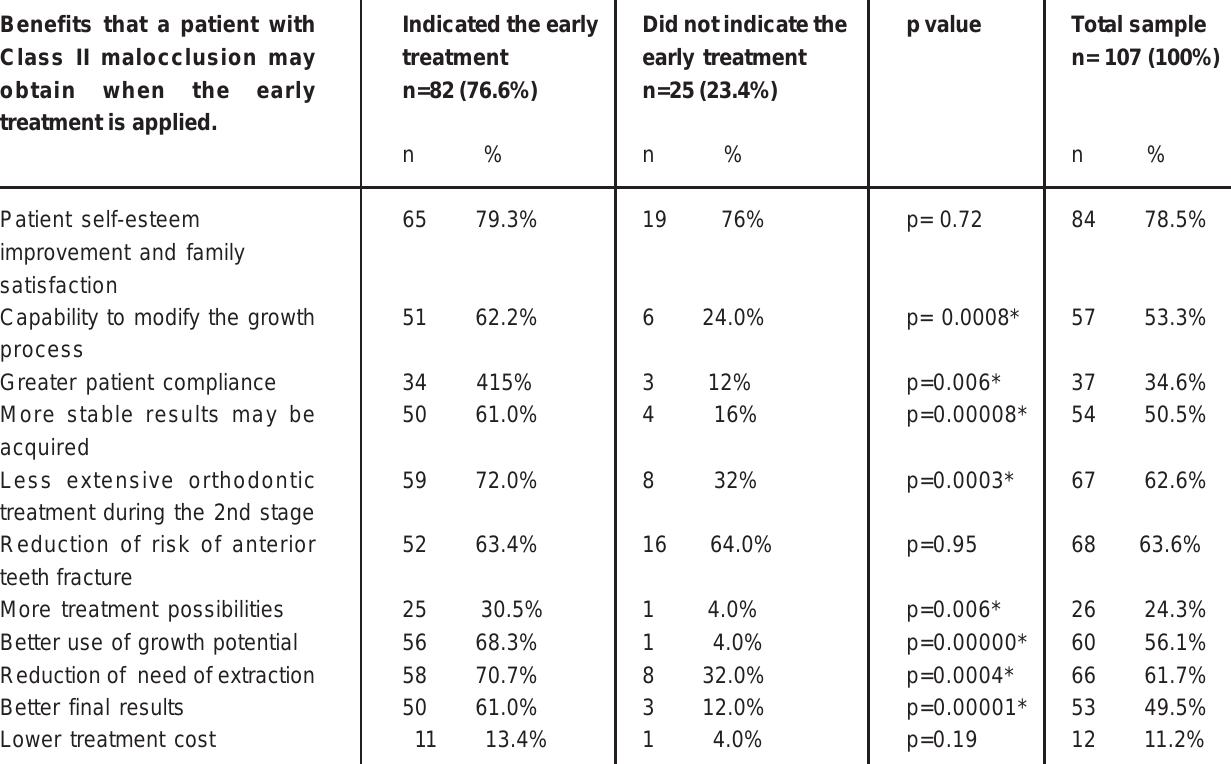
TABLE 2- Benefits mentioned by professors for the Class II malocclusion early treatment